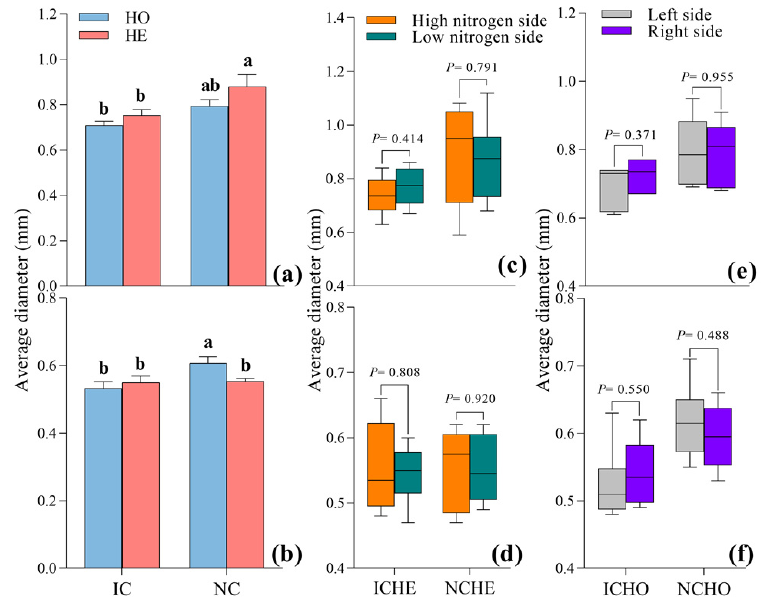
Figure 6. The effect of nitrogen distribution pattern and intraspecific competition on root average diameter. ( a ) Average diameter at flowering stage. ( b ) Average diameter at mature stage. ( c ) Average diameter with heterogeneous distribution of nitrogen at flowering stage. ( d ) Average diameter with heterogeneous distribution of nitrogen at mature stage. ( e ) Average diameter with homogeneous distribution of nitrogen at flowering stage. ( f ) Average diameter with homogeneous distribution of nitrogen at mature stage.